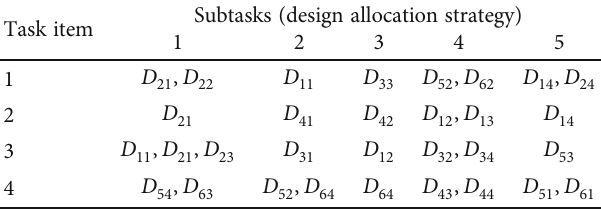
Table 16: Design allocation strategy.